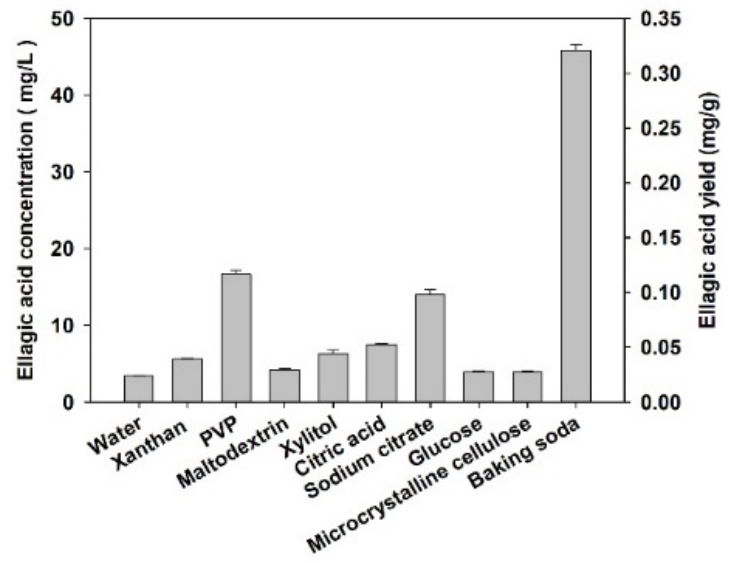
Figure 2. Ellagic acid extraction with different food additive solutions. Data are illustrated as mean + standard deviation ( n = 3).